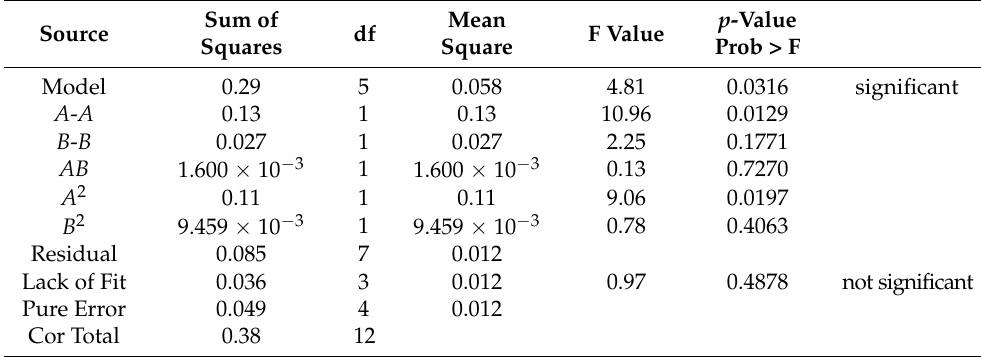
Table 4. ANOVA for the response surface quadratic model.